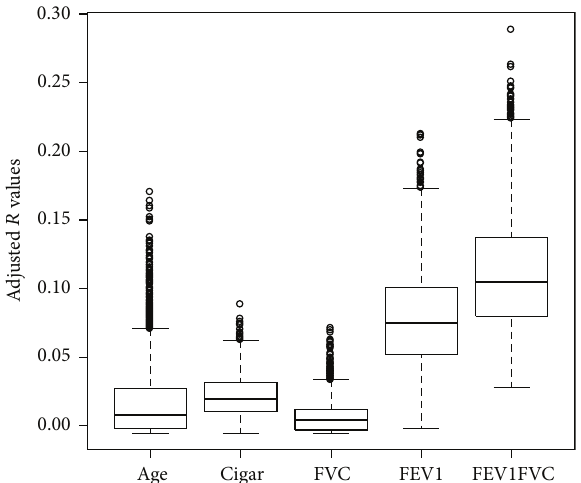
Figure 2: Regression analysis of the differentially expressed genes with clinical phenotypes. Genes were more associated with FEV 1 (forced expiratory volume in 1 second) and FEV 1 /FVC ratio (ratio of forced expiratory volume in 1 second to forced vital capacity) than with age and smoking history.